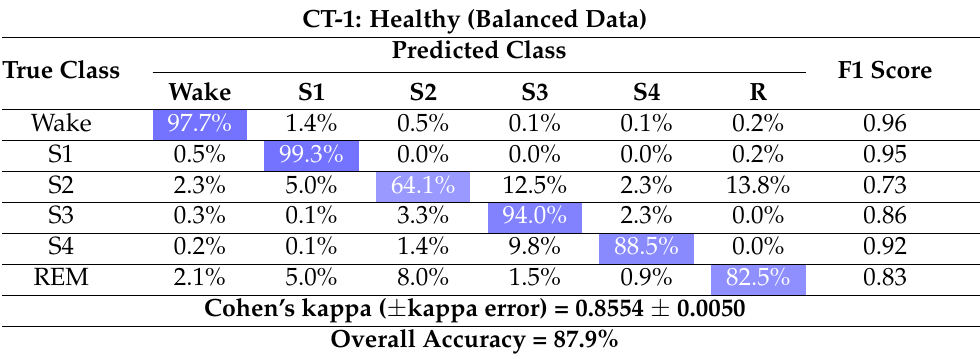
Table 10. Confusion matrix corresponding to sleep stage classification of healthy subjects with balanced data using the EBT classifier with 10-fold CV.